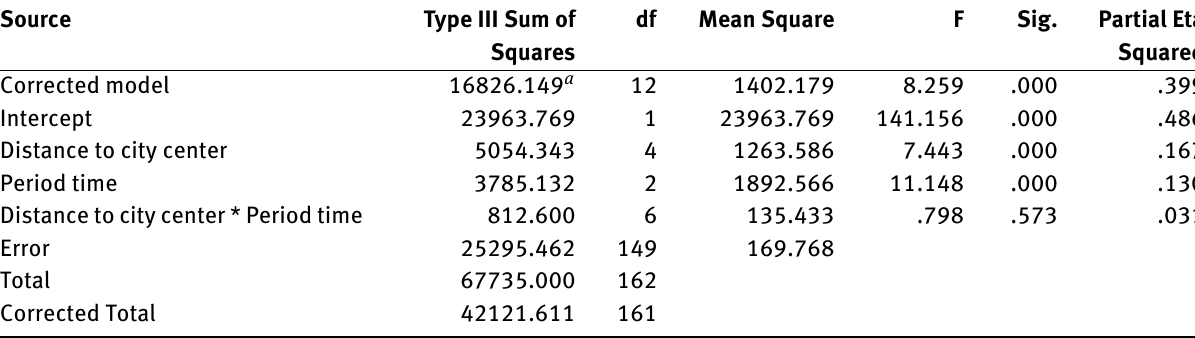
Table 2: Two-way ANOVA Results